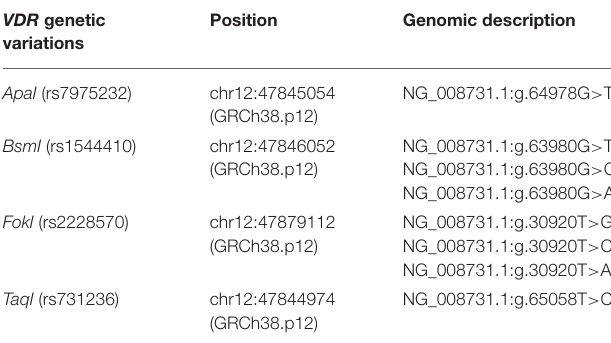
TABLE 1 | Genetic nomenclature used in this meta-analysis according to the recommendations of the Human Genome Variation Society (HGVS) and the American College of Medical Genetics and Genomics (ACMGG). VDR genetic